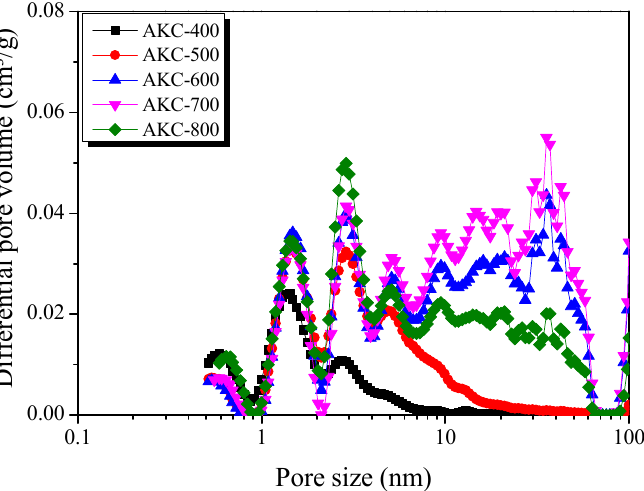
Figure 5. Pore size distribution of kenaf-derived activated carbons as a function of various phosphoric acid activation temperature.